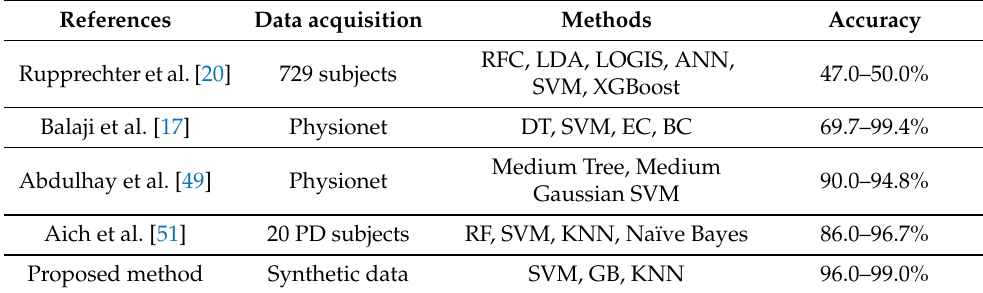
Table 6. Comparison of accuracies obtained with other